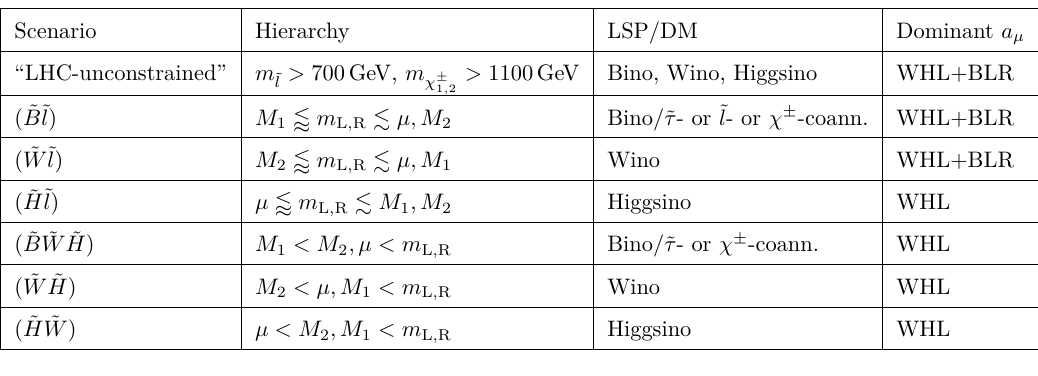
Table 3. Overview of the scenarios defined in section 6.3 and analysed in section 6.4. Here the / symbol denotes “lighter but not much lighter”, i.e. sufficiently close to evade LHC limits, see main text; the . symbol denotes “lighter or slightly heavier”. In each case, the nature of the dark matter candidate is indicated. In cases of Bino-like LSP we assume the dark matter density to agree with observation, which in turn requires one of the indicated coannihilation mechanisms to be